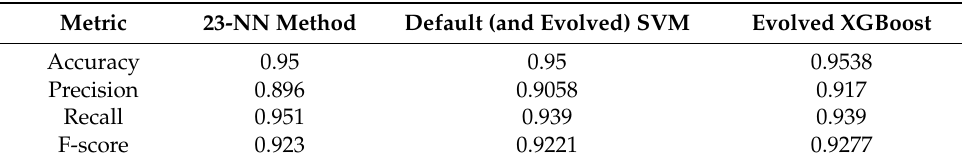
Table 13. Comparison of best classifiers.